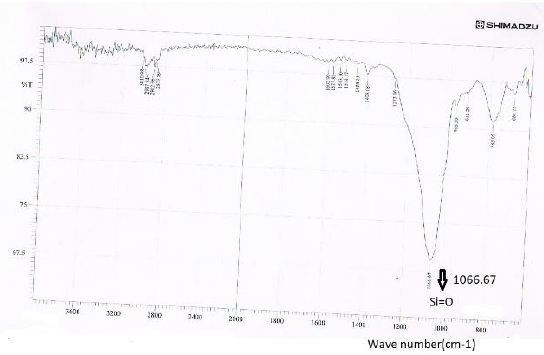
Figure 1: FTIR spectrum of SiO